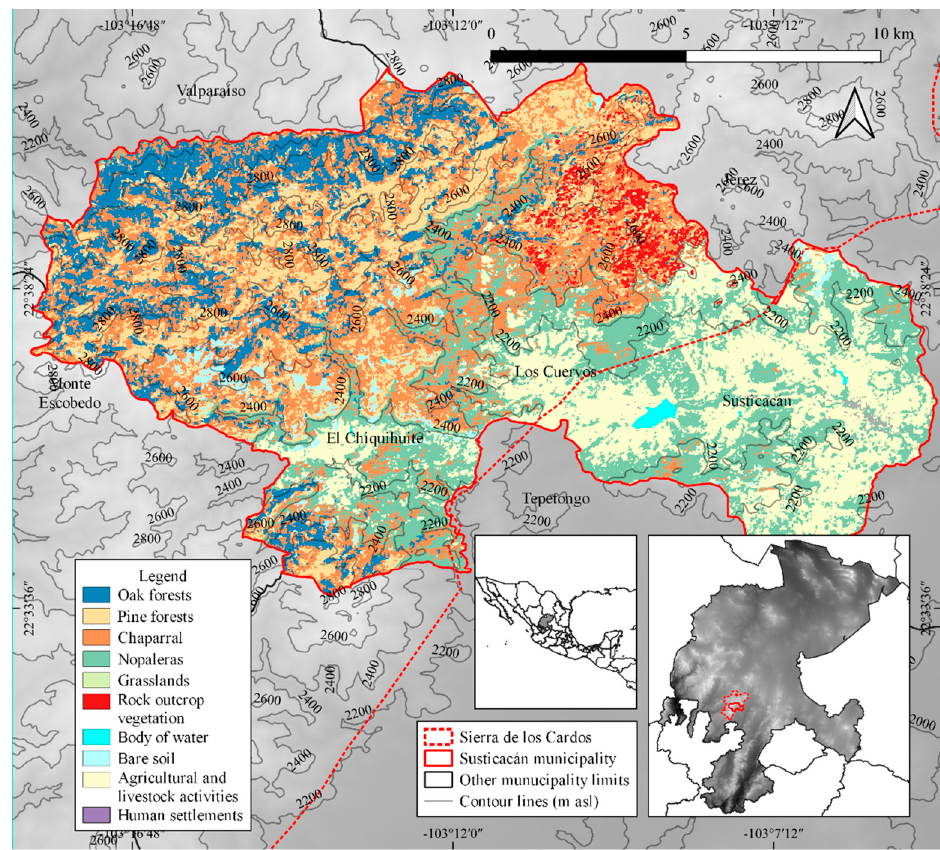
Figure 4. Distribution map of the vascular plant communities present in the Sierra de los Cardos, Susticacán, Zacatecas, Mexico.